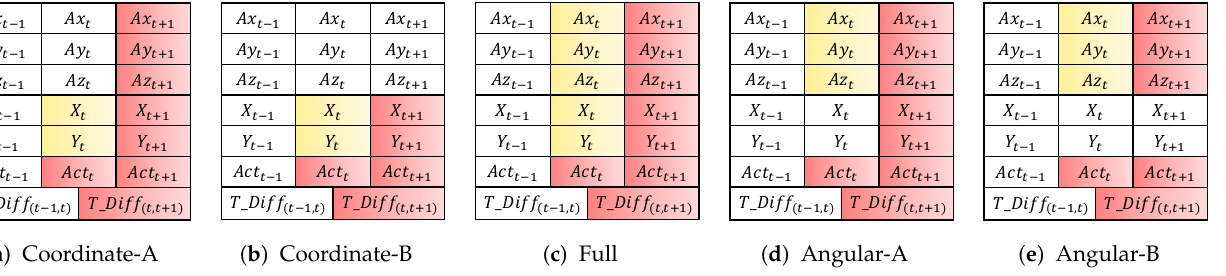
Figure 5. Input and output variables at time t based on five combinations of variable sets for the backward sequence (red and yellow denote input and output variables,